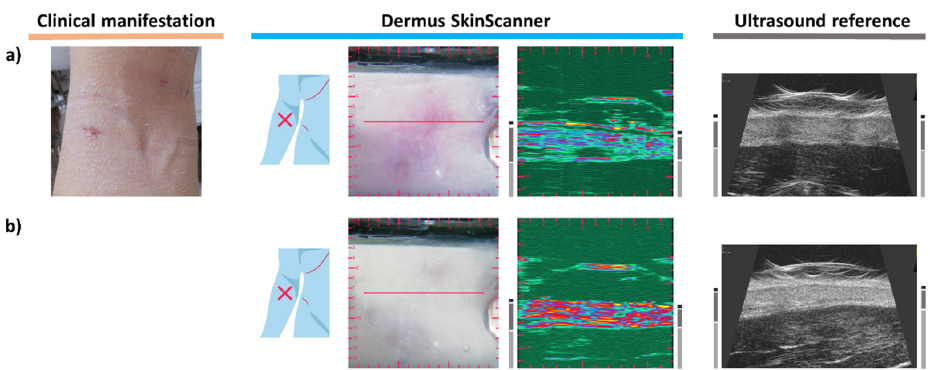
Figure 9. Examination images of the same skin area affected by atopic dermatitis before and after